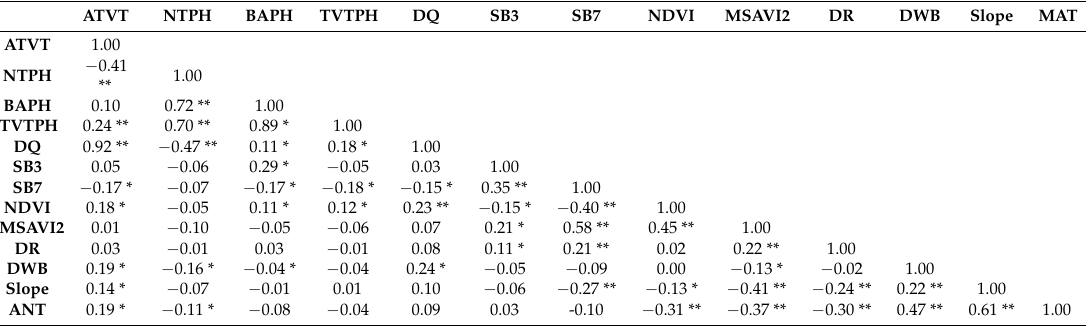
Table 2. Matrix of different variable correlations considered in the analysis.